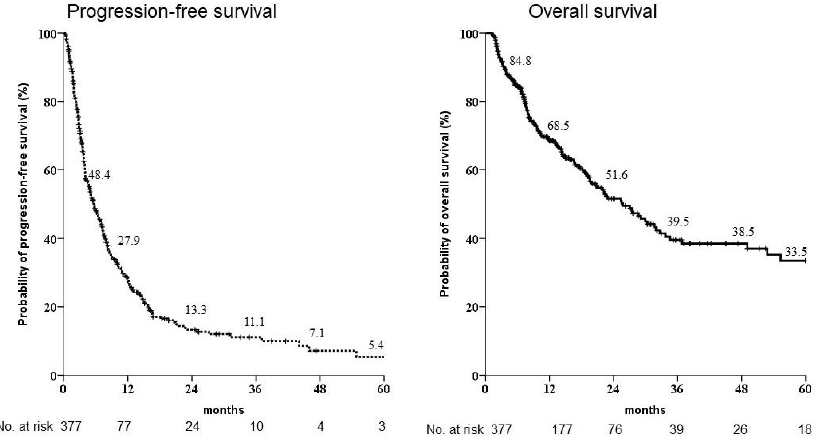
Figure 1. Kaplan-Meier estimates of survival rates of the 377 patients enrolled for sorafenib admin- istration as first-line treatment. The progression-free survival rates at 1, 2 and 3 years were 27.9%, 13.3% and 11.1%, respectively, whereas the overall survival rates after 1, 2 and 3 years were 68.5%, 51.6% and 39.5%, respectively.